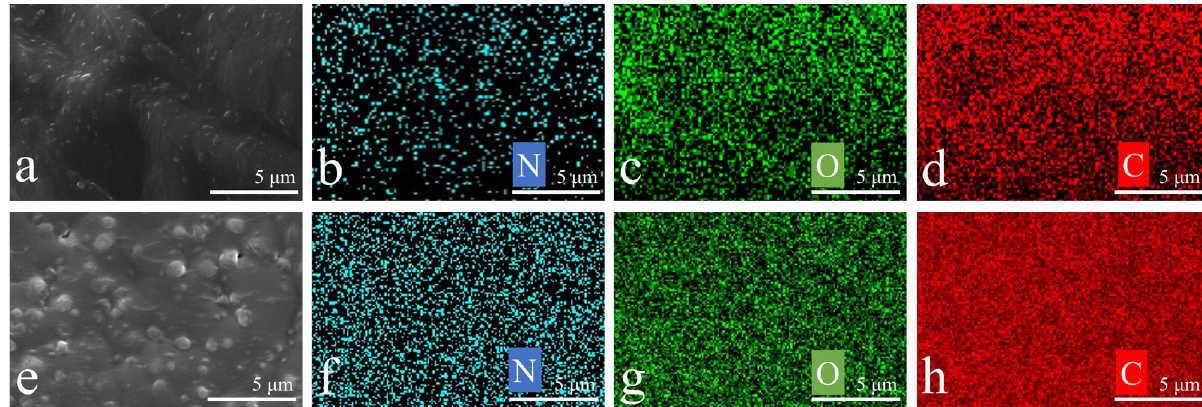
Figure 3: SEM - EDS images of ( a – d ) PBAT - CS10 and ( e – h ) PBAT -